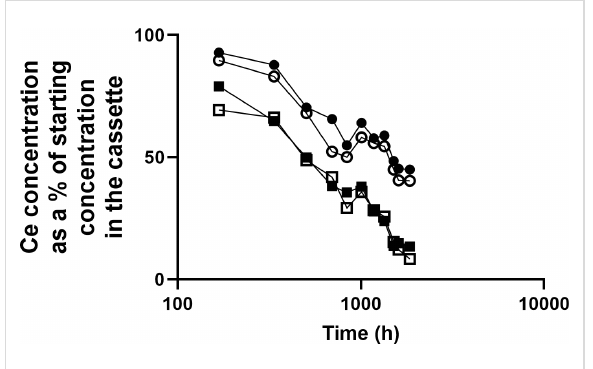
Figure 11: Addition of LN resin and HTP to the dialysis bath did not affect nanoceria dissolution. Solid circles: with HTP at pH 7.4, open circles: without HTP at pH 7.4, solid squares: with LN resin at pH 4.5, open squares: without LN resin at pH 4.5. Results are the mean of two